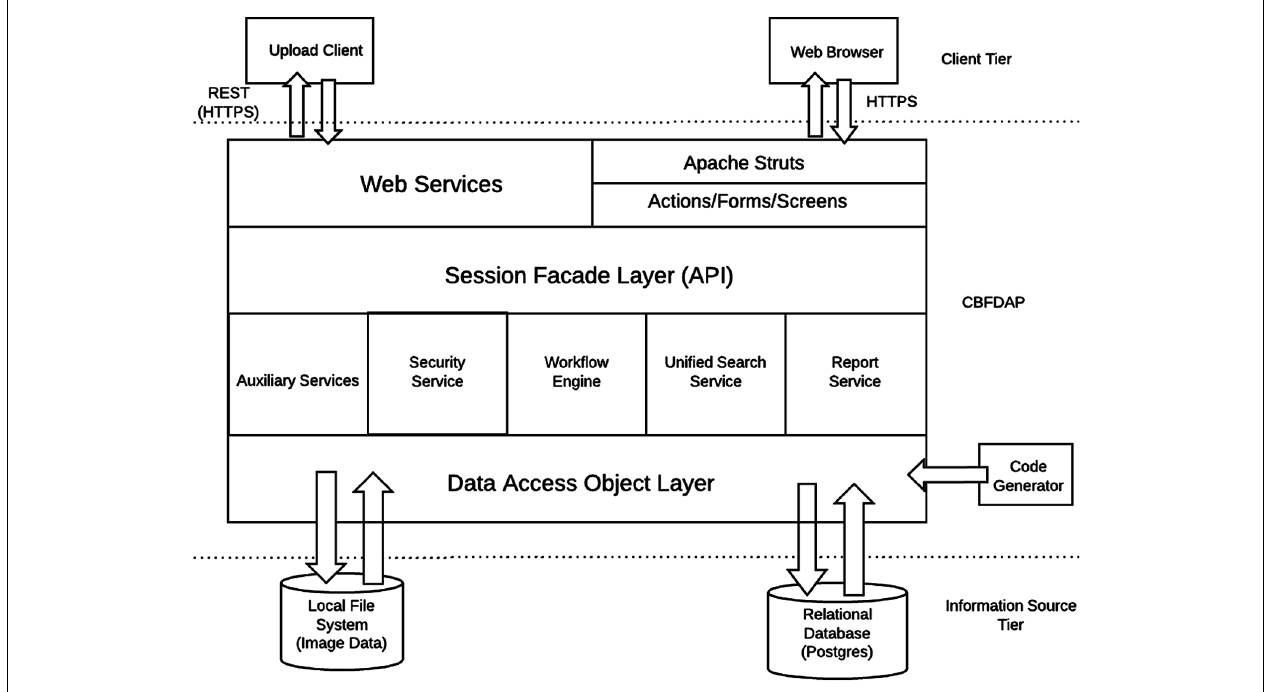
FIGURE 3 | Summary of CBFBIRN